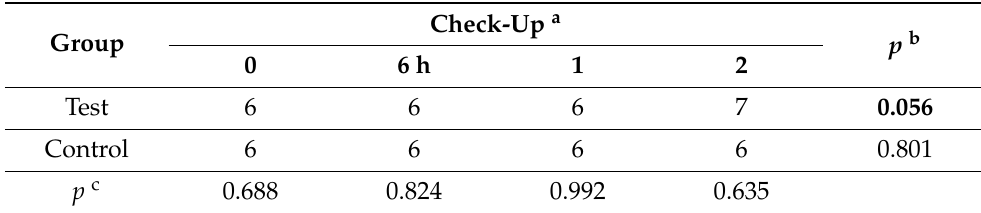
Table 8. Two-Point